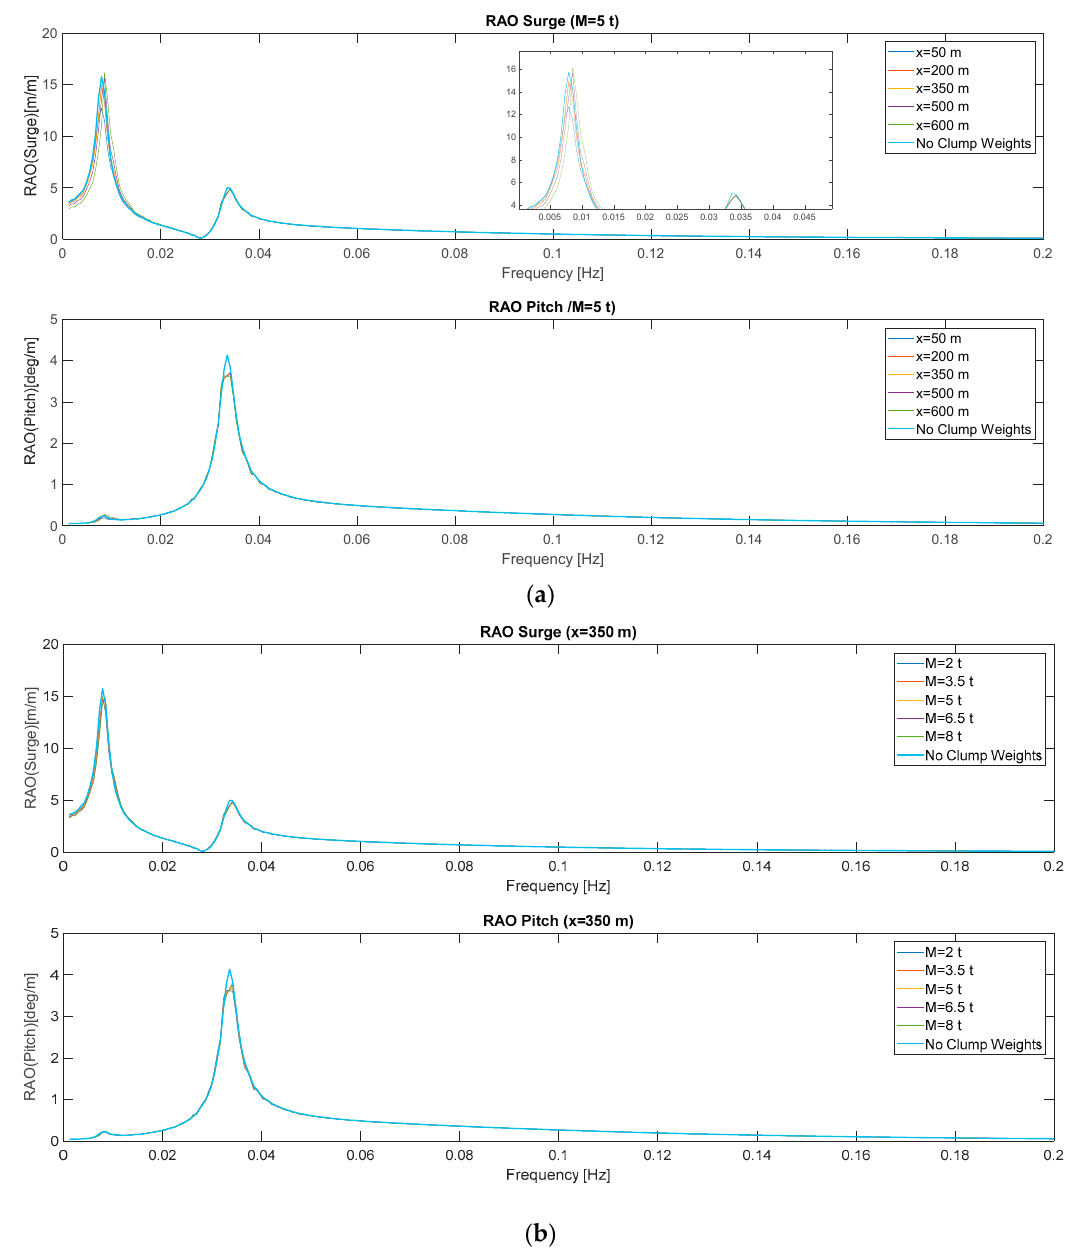
Figure 3. Pitch and Surge RAOs for different positions ( a ) and weights ( b ) of the cable ballast.